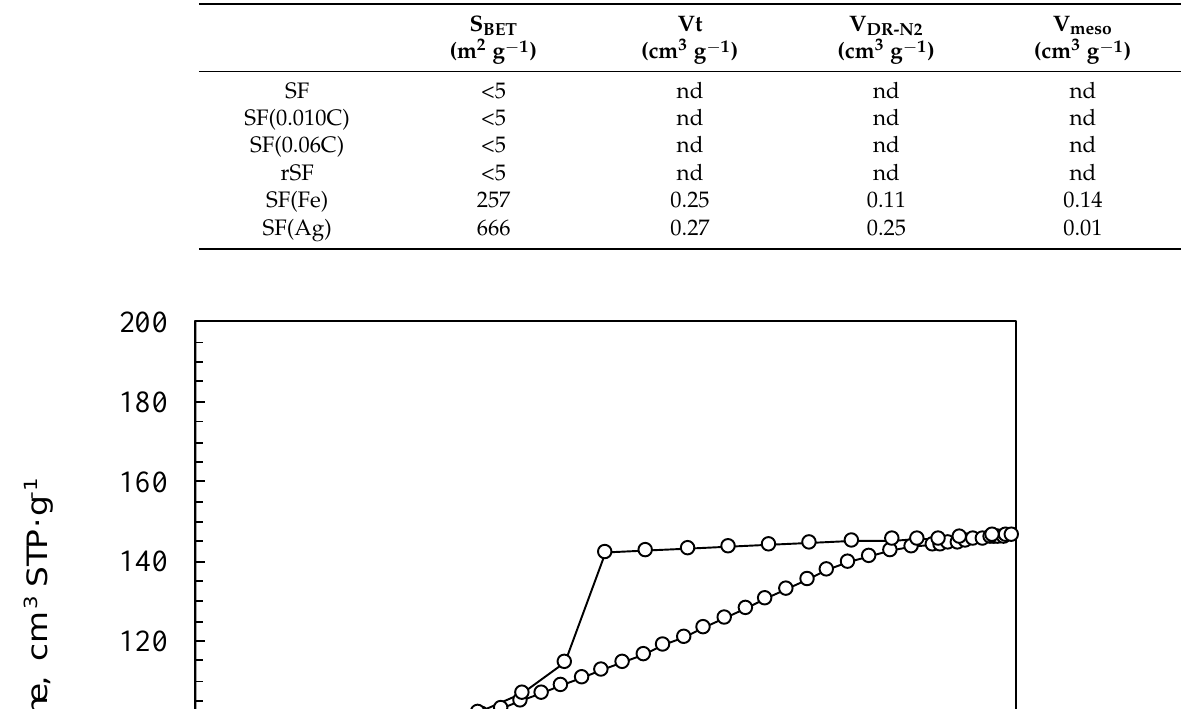
Table 4. BET specific surface areas, total pore volume (Vt), micropores volume (V DRN2 ), and mesopore volume (V meso ) of the foams.